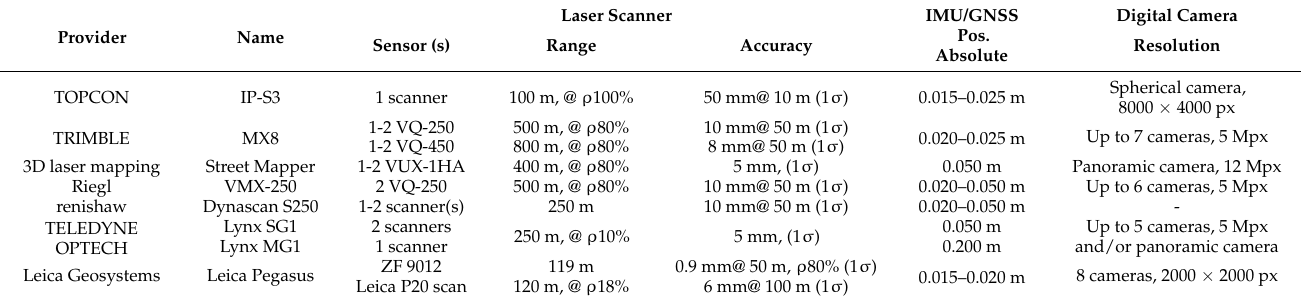
Table 21. The most common common commercial mobile cartography systems and related compo- nents post-processed precision data values such as